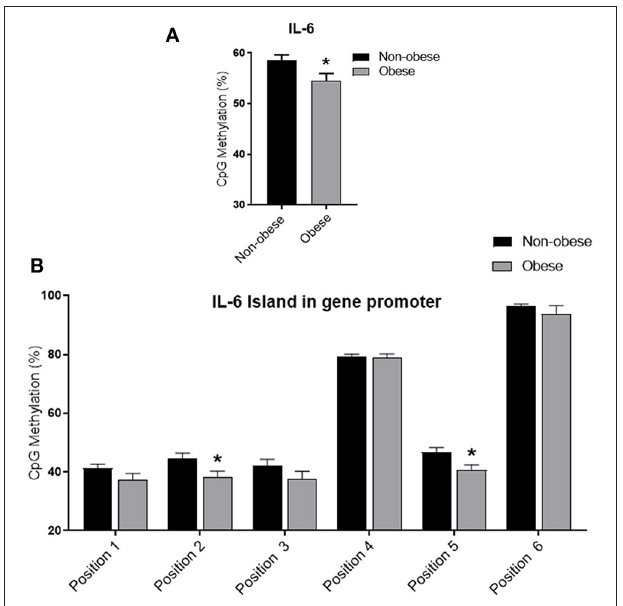
FIGURE 1 | Methylation analysis of IL-6 promoter in obese and non-obese subjects (A) Schematic representation of CpG site locations in human IL-6 promoter. (B) The DNA methylation status was expressed as percentage of CpGs methylation. Data are mean ± Standard Errors. * p < 0.05 vs. non-obese subjects.